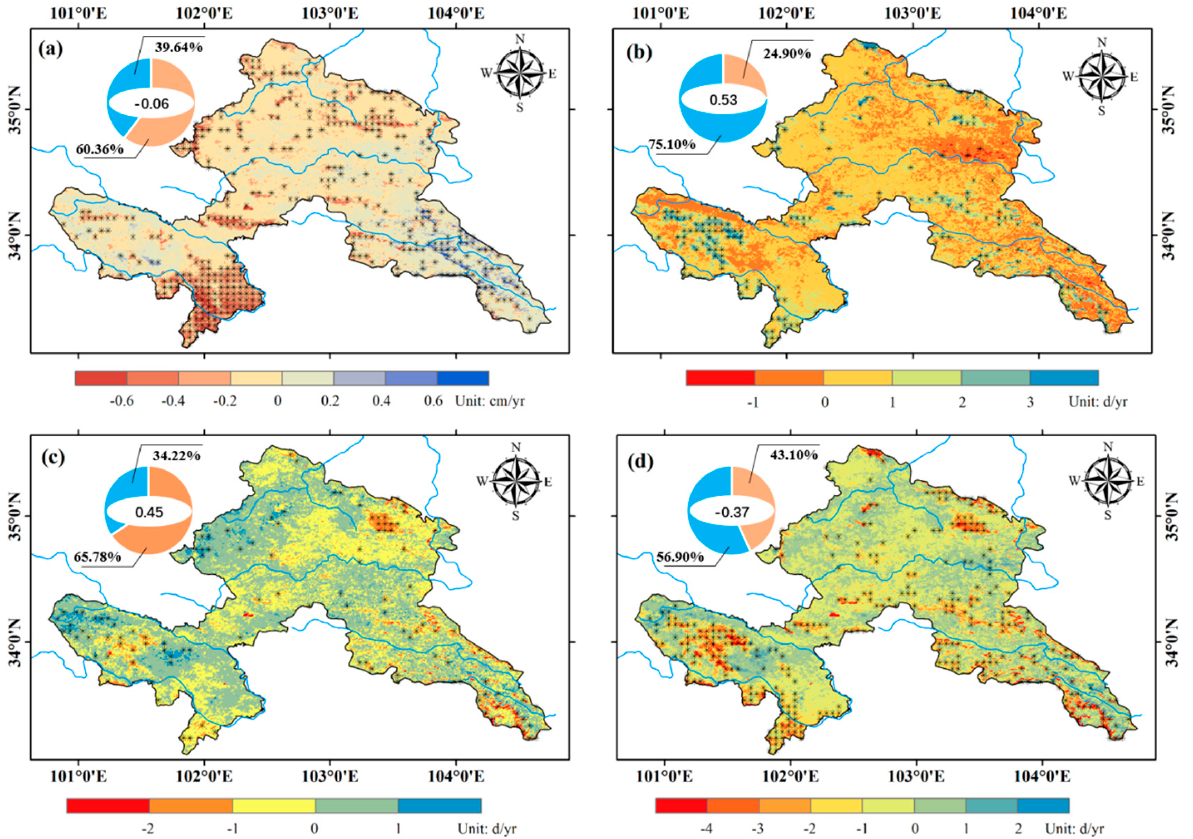
Figure 7. Spatial variation of the four selected LSSP indices across the SGP (2003–2018). Subplots ( a – d ) are for SD, SCS, SCM, and SCD in order). “ ∗ ” indicates an area with significantly tested LSSP series ( p ≤ 0.01). Fan diagrams in the upper left corners of the subplots indicate areal proportions of increasing and decreasing, differentiated using blue and orange, while regional averages are indicated by the white part in the middle.